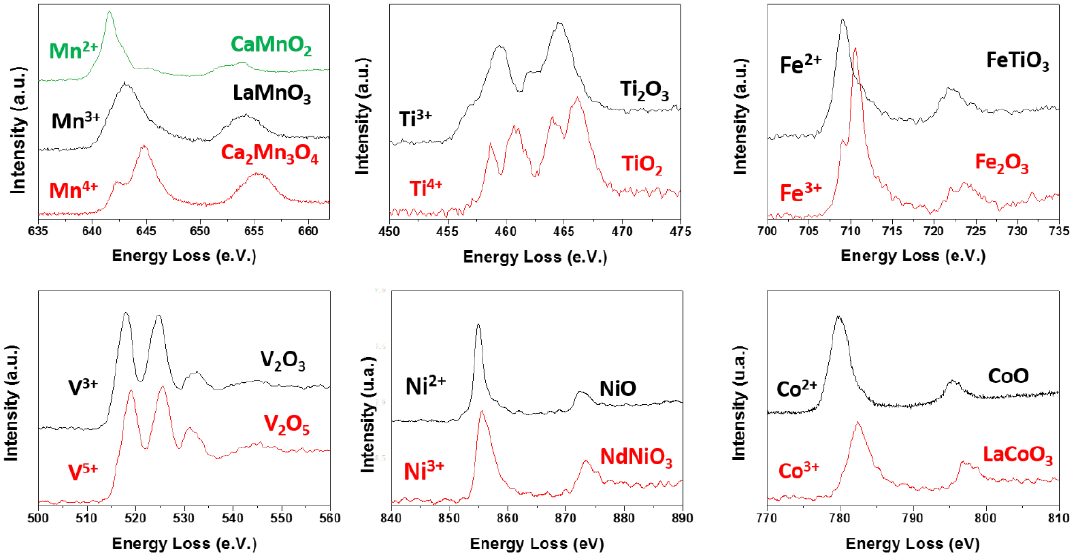
Figure 12. ML 2,3 edges for several oxides containing M = Mn, Ti, Fe, V, Ni, and Co in different oxidation states. These spectra can be used as standards for the identification of the M oxidation state